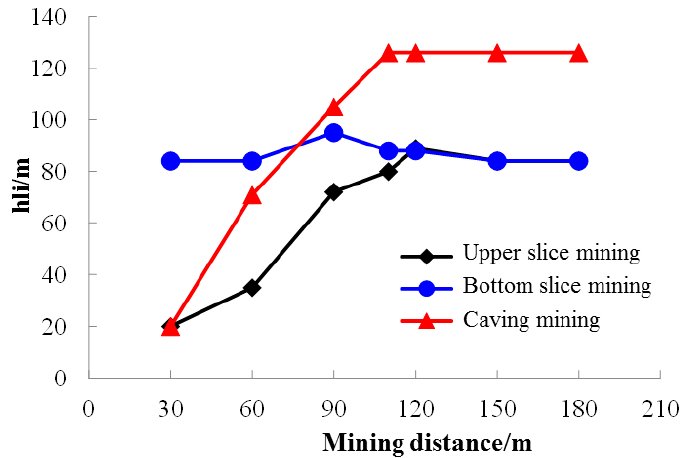
Figure 7. Variations in heights of FWCZ under different caving methods.